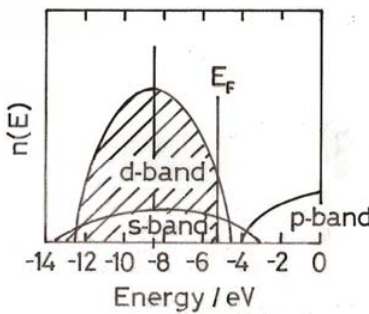
Figure 1. Distribution of energy levels for a large (20 nm) particle; note E top of the d -band, accounting for the existence of a small white